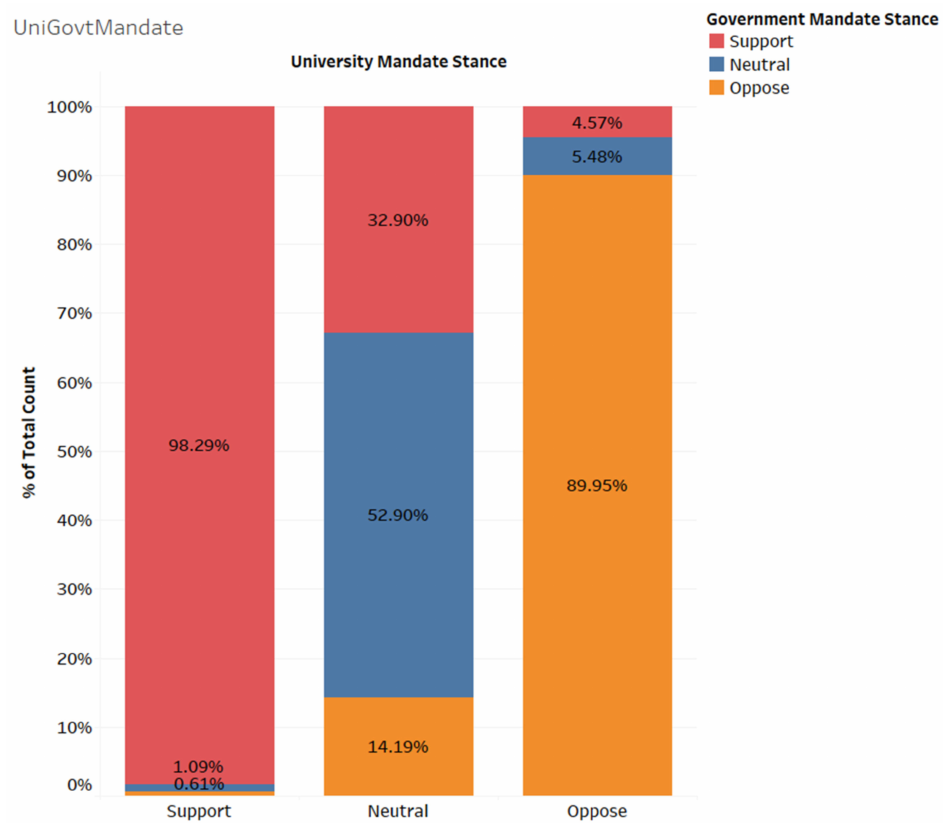
Figure 1. Support for University and Government